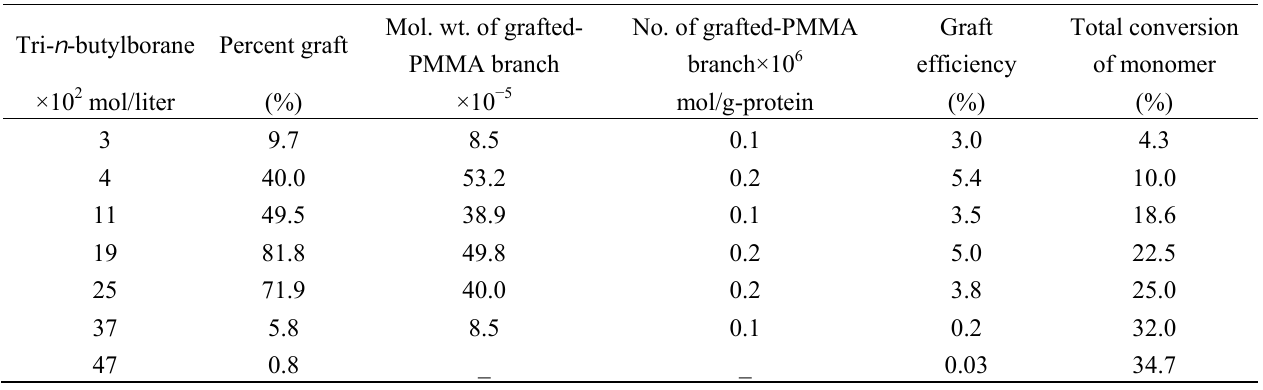
Table 4. Effect of the concentration of tri- n -butylborane on the graft copolymerization of MMA onto hydrated bovine dentin